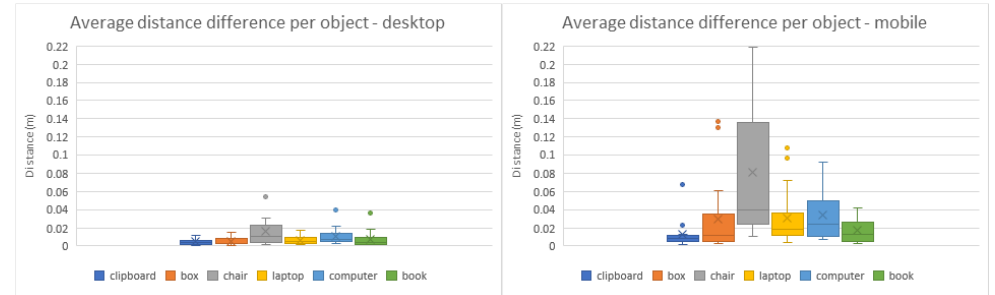
Figure 12. Box plots of the average distance from each virtual object placed to its target position in the desktop ( left ) and mobile ( right ) methods.